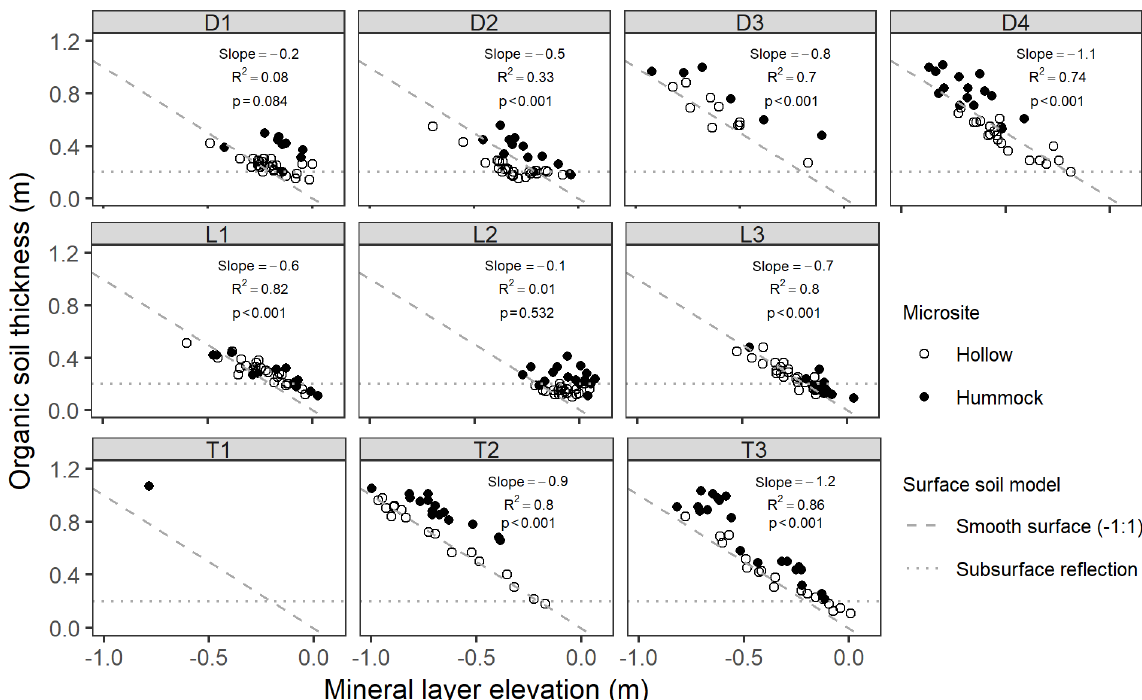
Figure 6. Organic soil thickness (measured as depth to resistance) as a function of mineral layer elevation. Points are filled by their microsite. The dashed ( − 1 : 1) line indicates a smooth surface soil model, and the dotted horizontal line indicates a subsurface reflection model. Text values are slopes, R 2 , and p values of the best-fit linear model for aggregated hummock and hollow